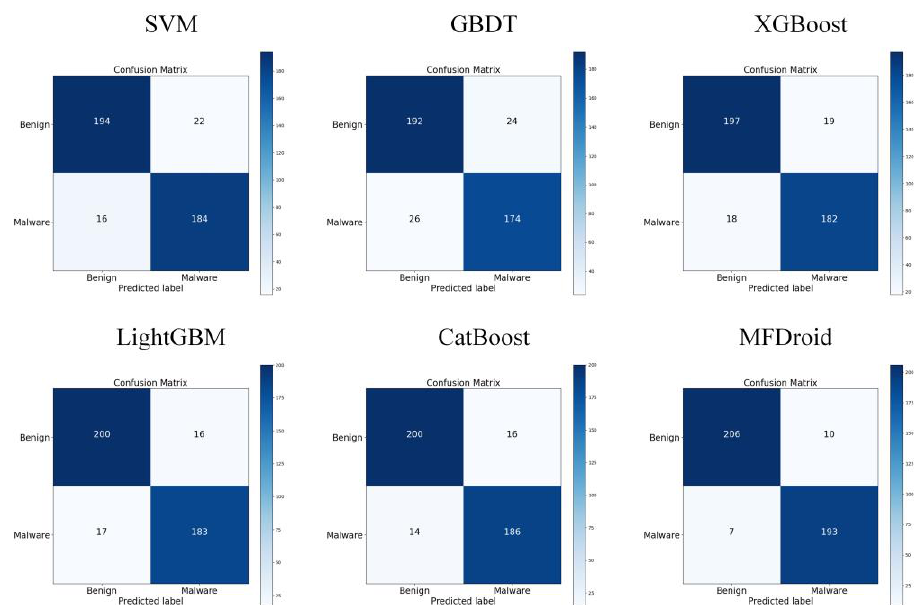
Figure 12. Confusion matrix of MFDroid and single